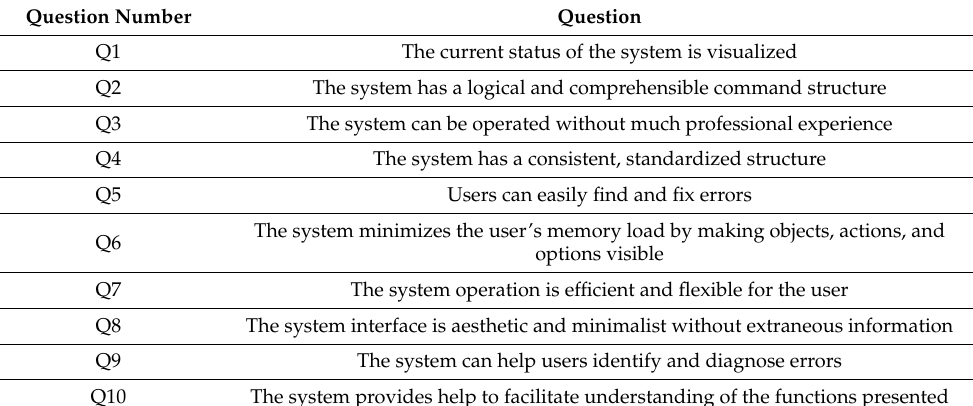
Table 2. Evaluation questionnaire of QDARV development tool.